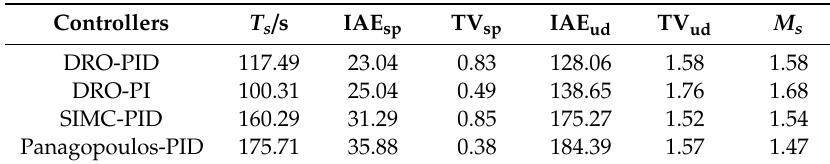
Figure 13. The control signal of the step set-point and input disturbance for Example 3. Table 8. The indices of Example 3 with different controllers. Table 8. The indices of Example 3 with di ff erent controllers.